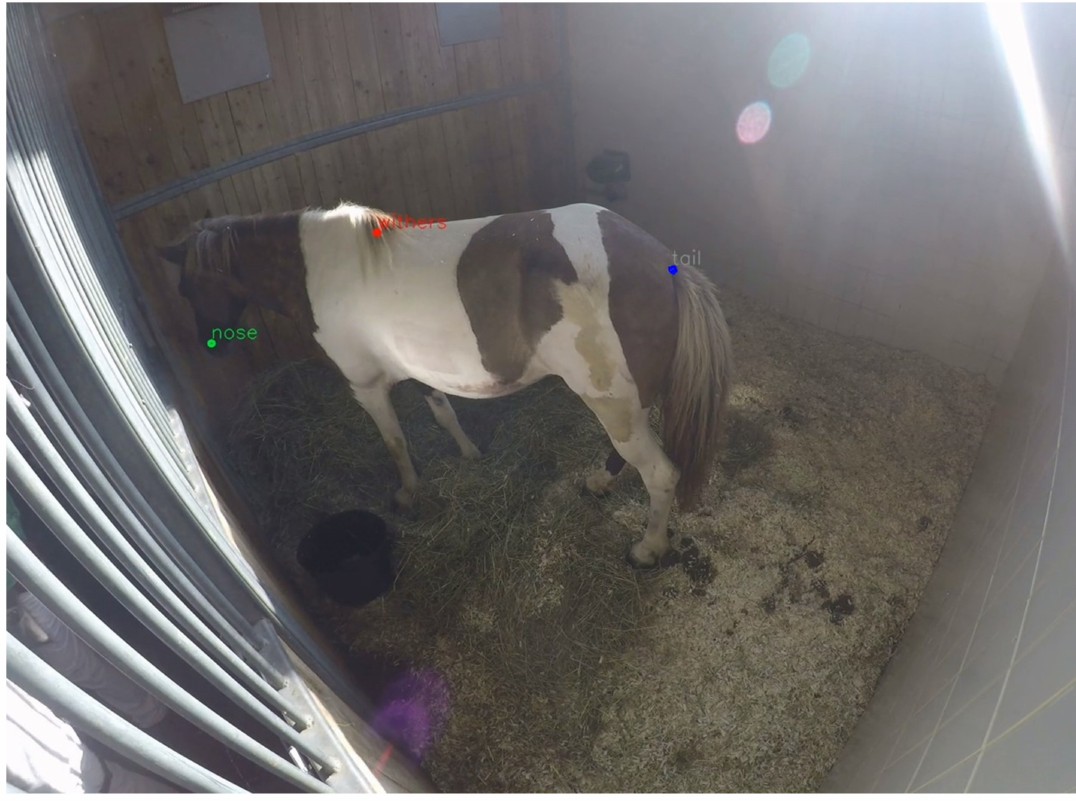
Figure 1. Screen shot of a video of the horse from the case example with the visible predicted marker nose (green), withers (red) and tail